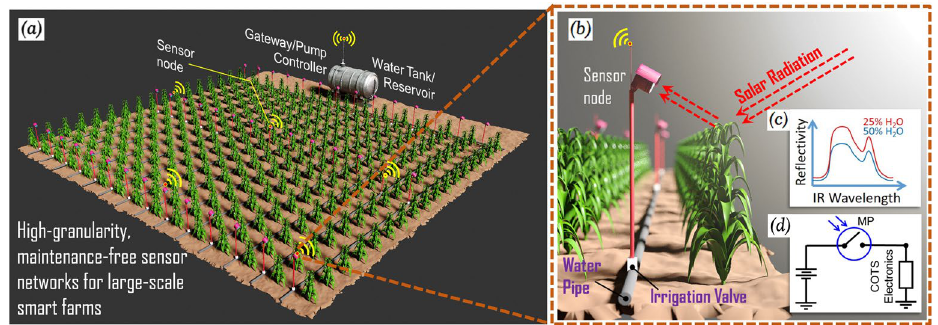
Figure 1. ( a ) Schematic illustration of our vision for a smart farm employing the proposed zero-power and low-cost sensor nodes in a crop field with high spatial granularity. ( b ) Schematic of the wireless sensor node used for non-contact water stress detection in plants. Upon plant water-stress detection, the switch closes and connects the battery to active electronics. e.g. a wireless transmitter that remotely triggers an automated irrigation system. The sensor remains otherwise OFF with zero drain on the battery. ( c ) Water stress-dependent IR reflectance characteristic of plants. As the plant becomes water stressed, the reflectance of the leaf in the SWIR wavelength region increases, causing a higher intensity of IR radiation to be reflected off the leaf surface when illuminated by the sun. ( d ) Simplified schematic of the circuit functionality showing the plasmonically- enhanced micromechanical photoswitch (PMP) controlling the current between the battery and the COTS